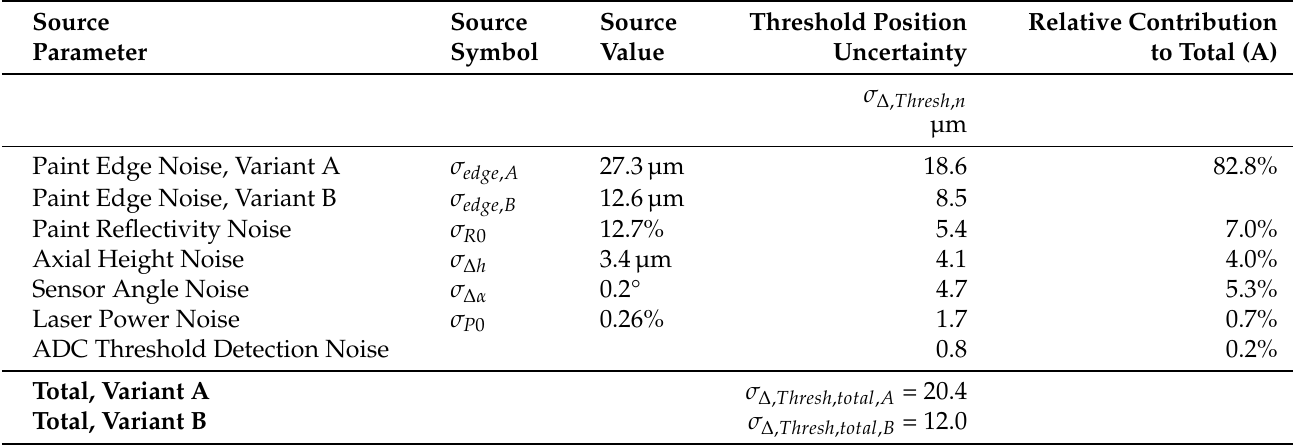
for Variant , Thresh , total , A